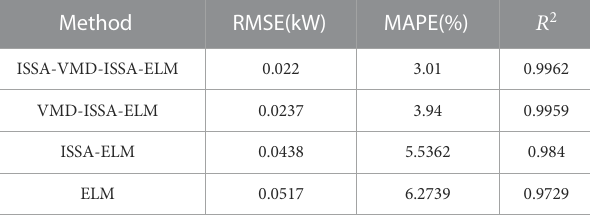
TABLE 6 Evaluation indexes of different models in three kinds of